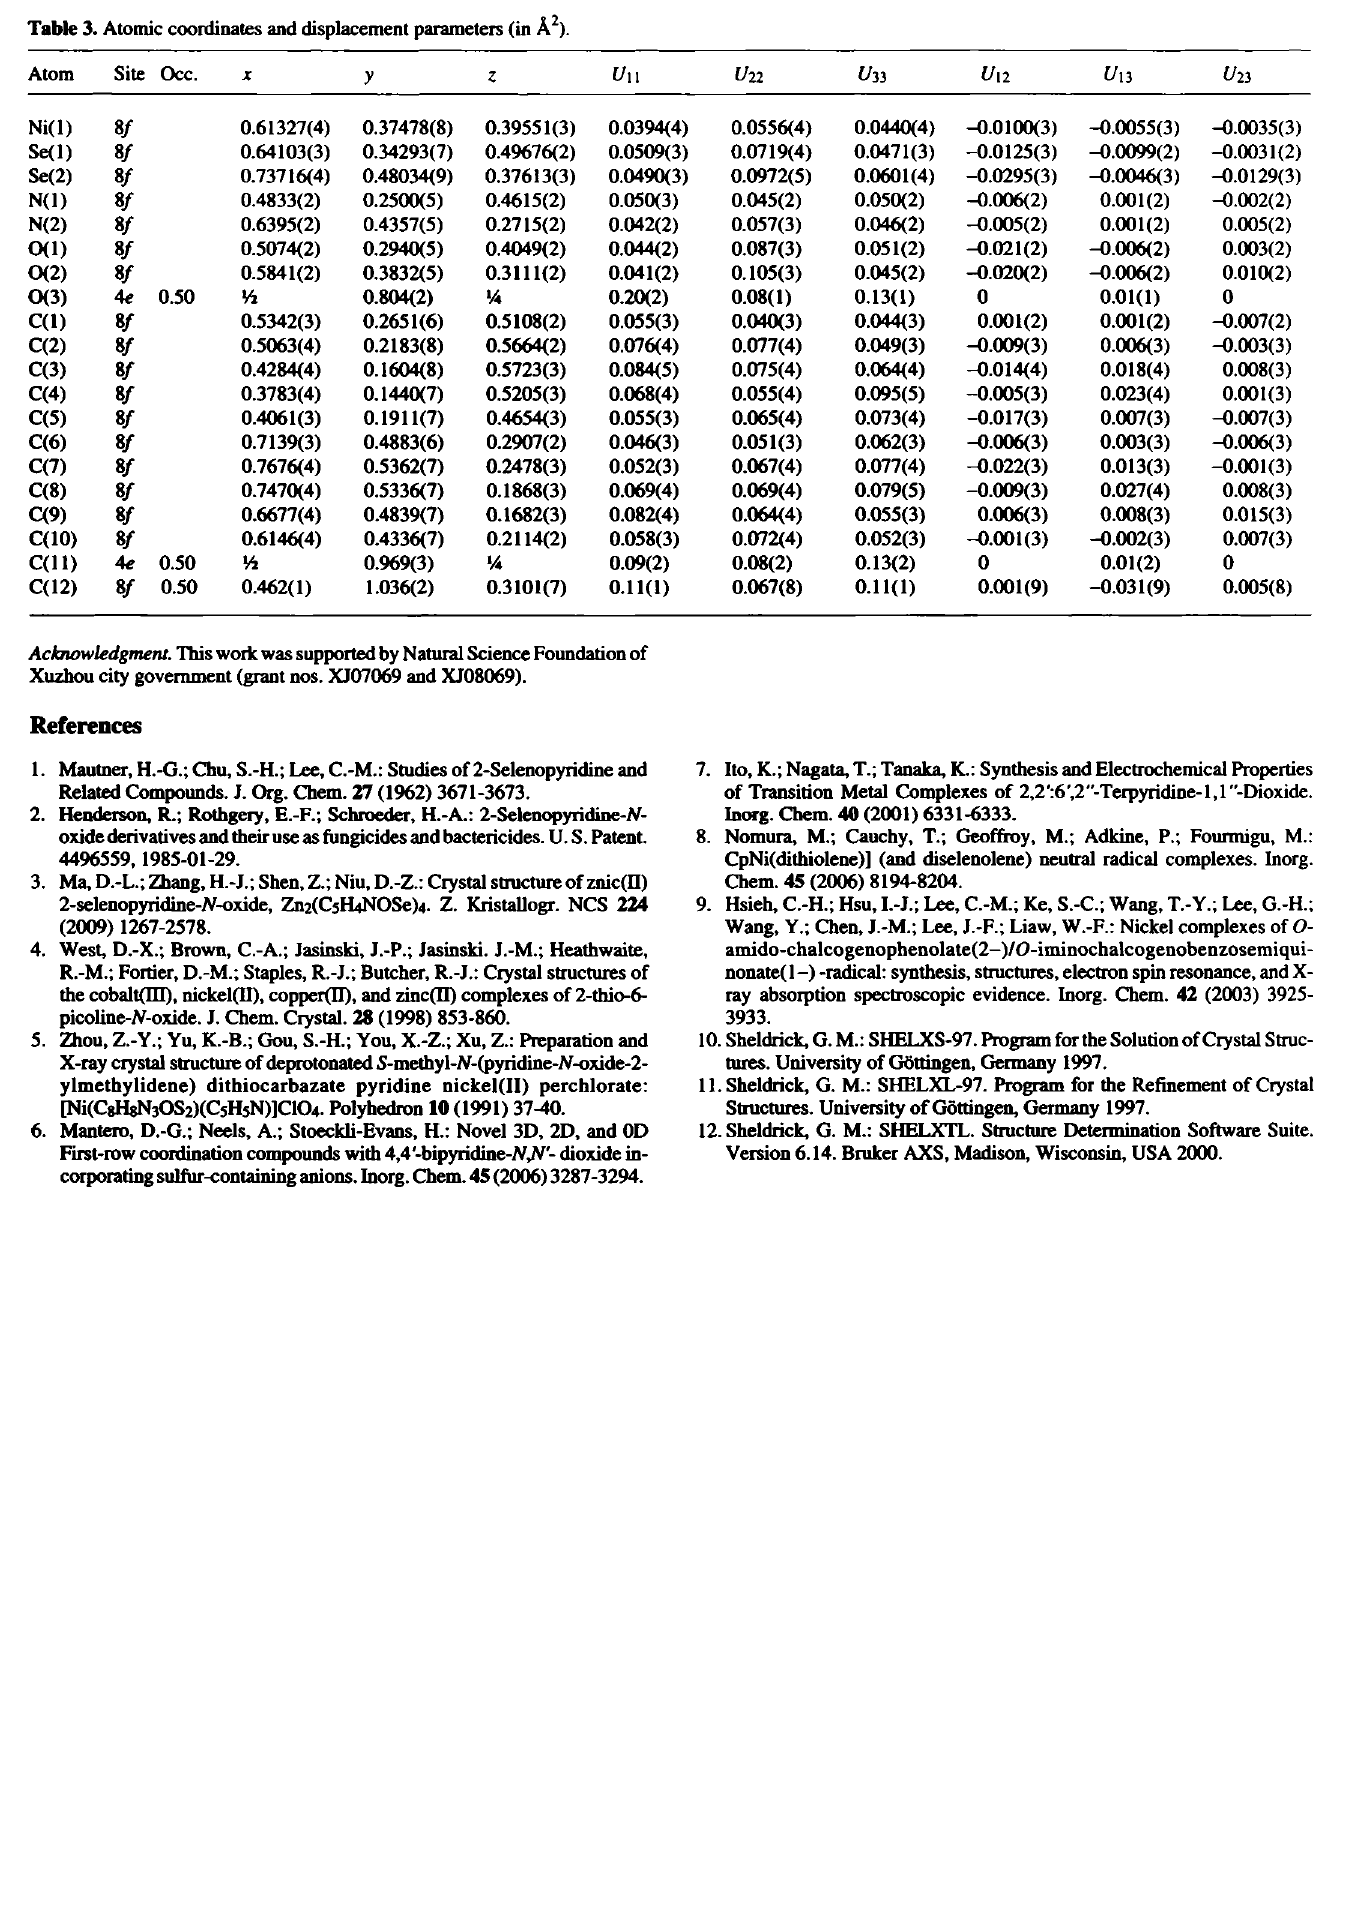
Table 3. Atomic coordinates and displacement parameters (in Â 2